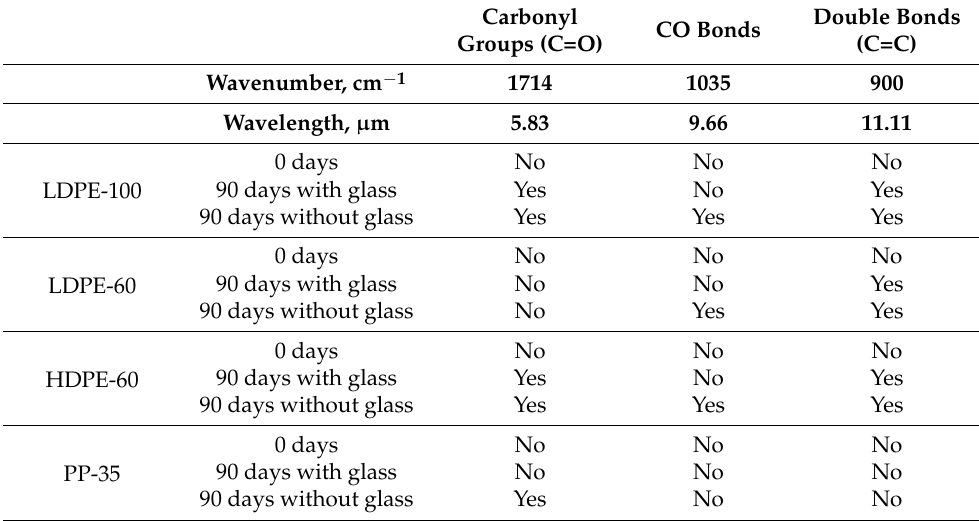
Table 4. FT-IR spectra qualitative analysis.